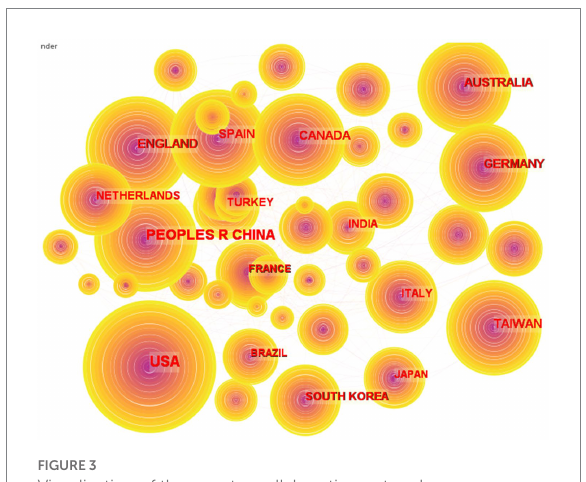
FIGURE 3 Visualization of the country collaboration network.